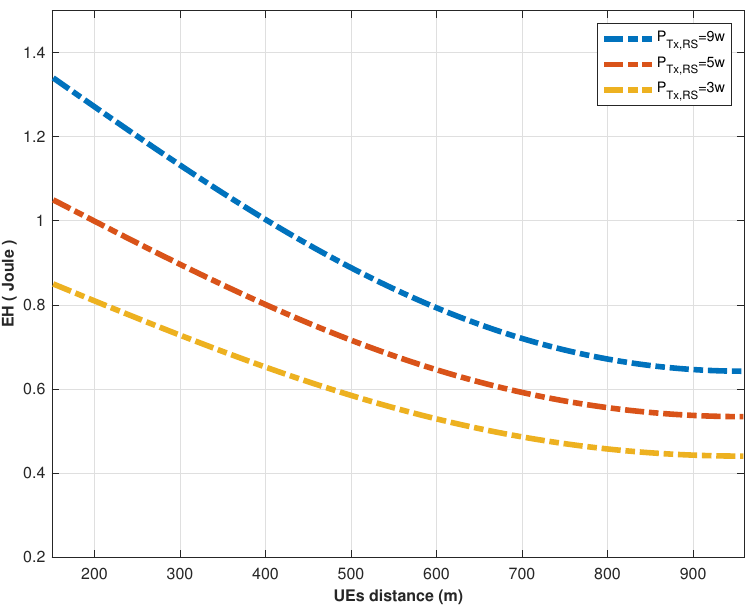
Figure 10. EH vs. MCHs distance from RS at different signal power transmitting by